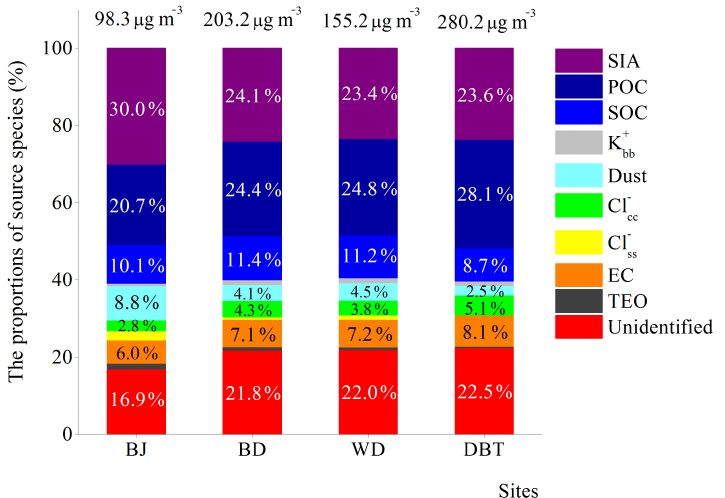
Figure 11. The proportions of source species under the constructed chemical mass closures for PM 2 . 5 at the four sampling sites during the sampling period in the winter of 2015. Average mass concentrations of PM 2 . 5 at each sampling site, including all of source species and unidentified fractions, are also marked above the bars.